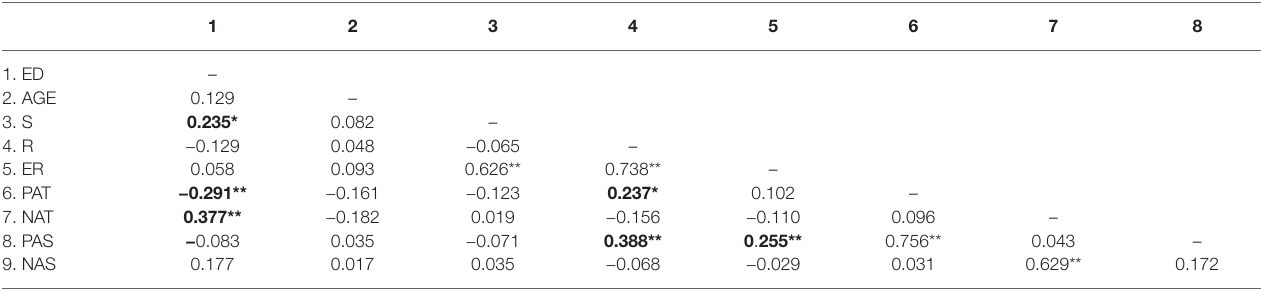
TABLE 5 | Correlations between variables in control group: S (expressive suppression), R (cognitive reappraisal), ER (emotion regulation measured as total score of ERQ), PAT (positive affect of trait), NAT (negative affect of trait), PAS (positive affect of state), NAS (negative affect of state), ED (emotion dysregulation measured as total score of DERS), and AGE. The relevant values are presented in bold format.